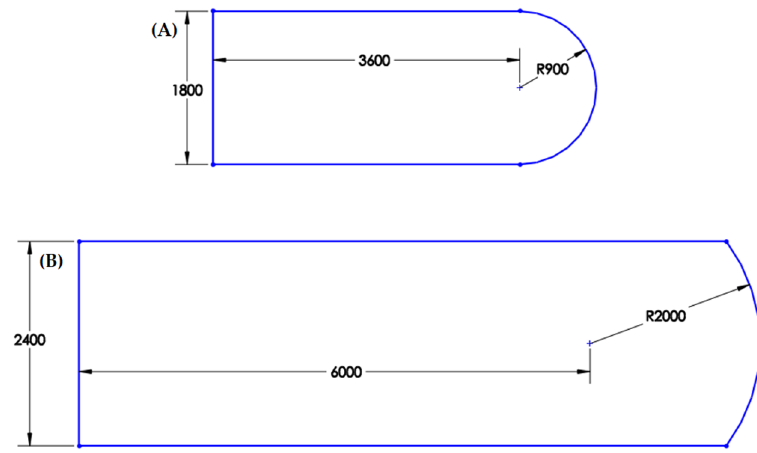
Figure 2. Vehicle geometries: car ( A ) and bus ( B ).